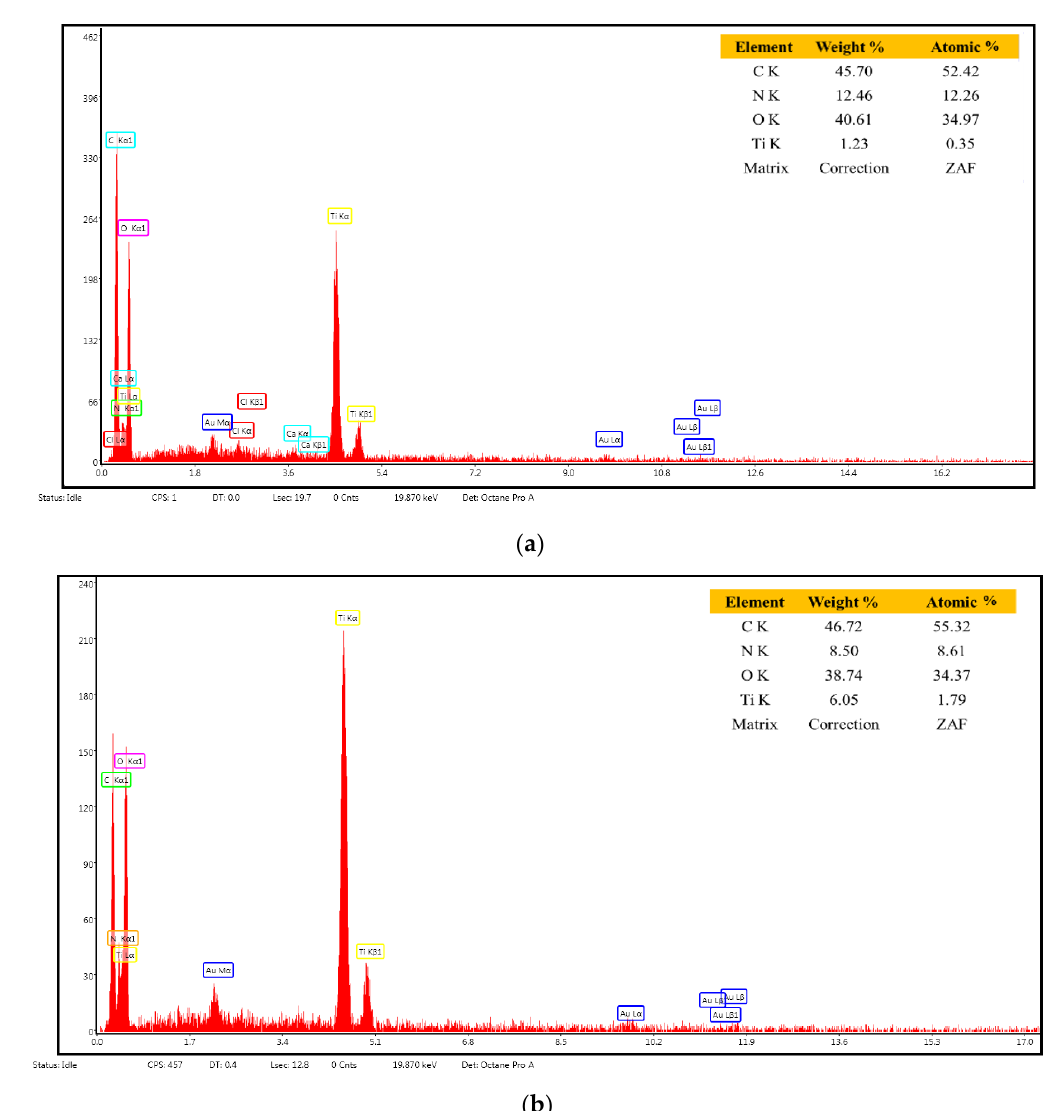
Figure 11. EDX spectra and elemental composition: ( a ) chitosan/TiO 2 1%, ( b ) chitosan/TiO 2 5%.